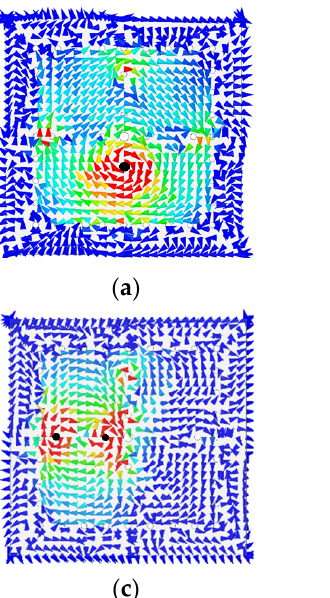
Figure 3. The electric field distribution on the top surface of metal layer M2 at the ( a ) first, ( b ) second, ( c ) third, and ( d ) fourth passband resonance frequencies.